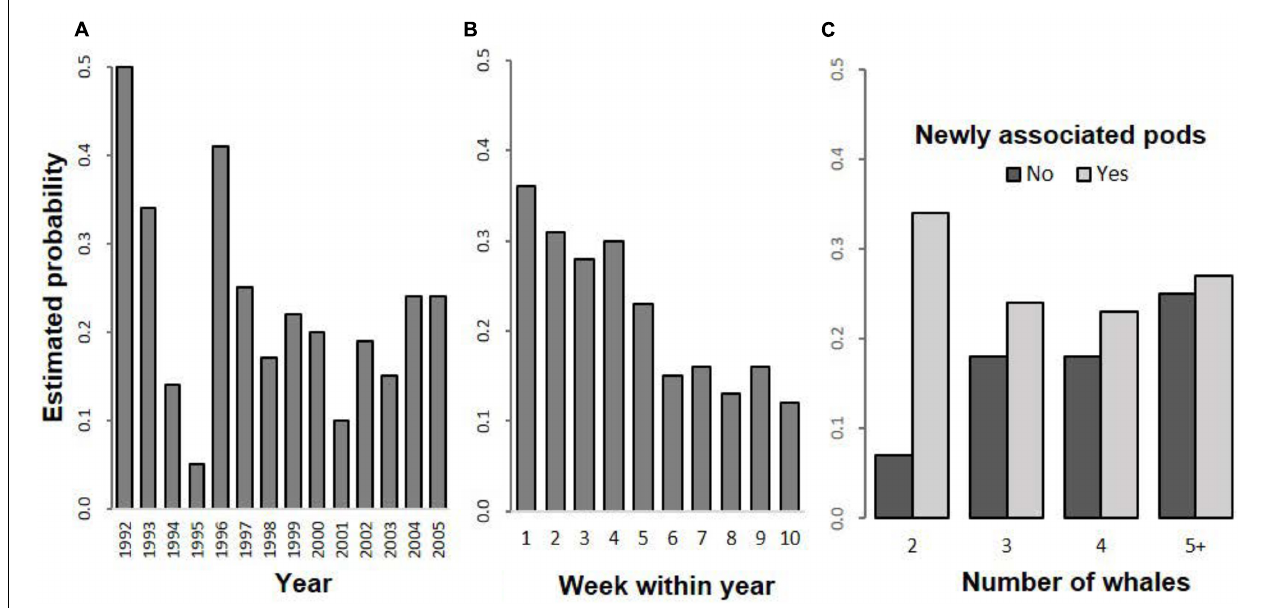
FIGURE 4 | Estimated probabilities of observing non-agonistic social behaviour: (A) by year; (B) by week within year; (C) by number of whales (excluding calves), in newly associated pods (No, Yes).